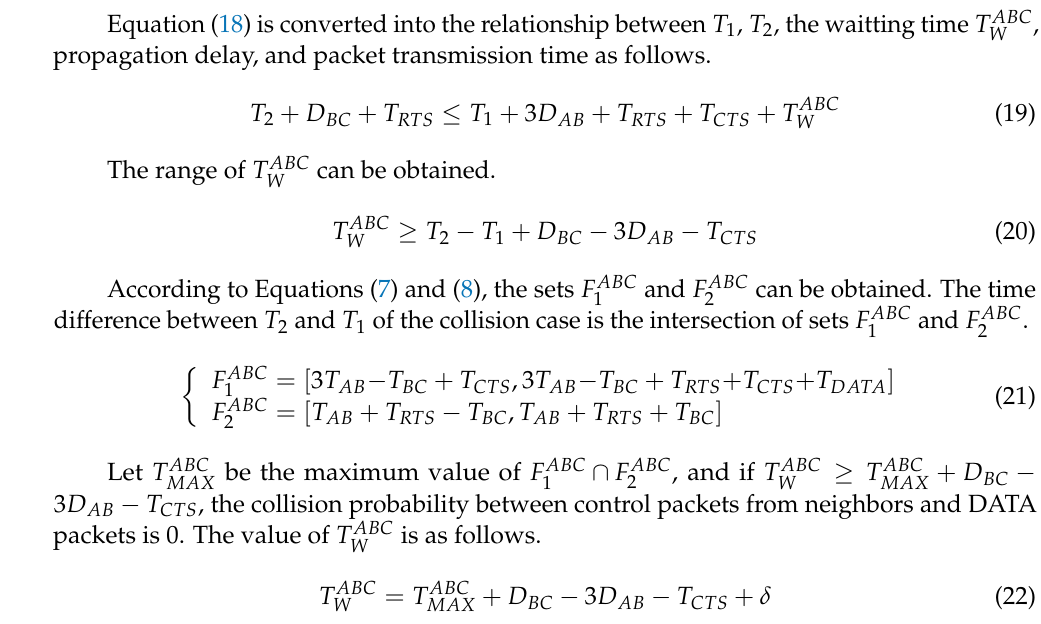
Figure 6. Avoid collisions between control packets from neighbors and DATA packets by the waiting